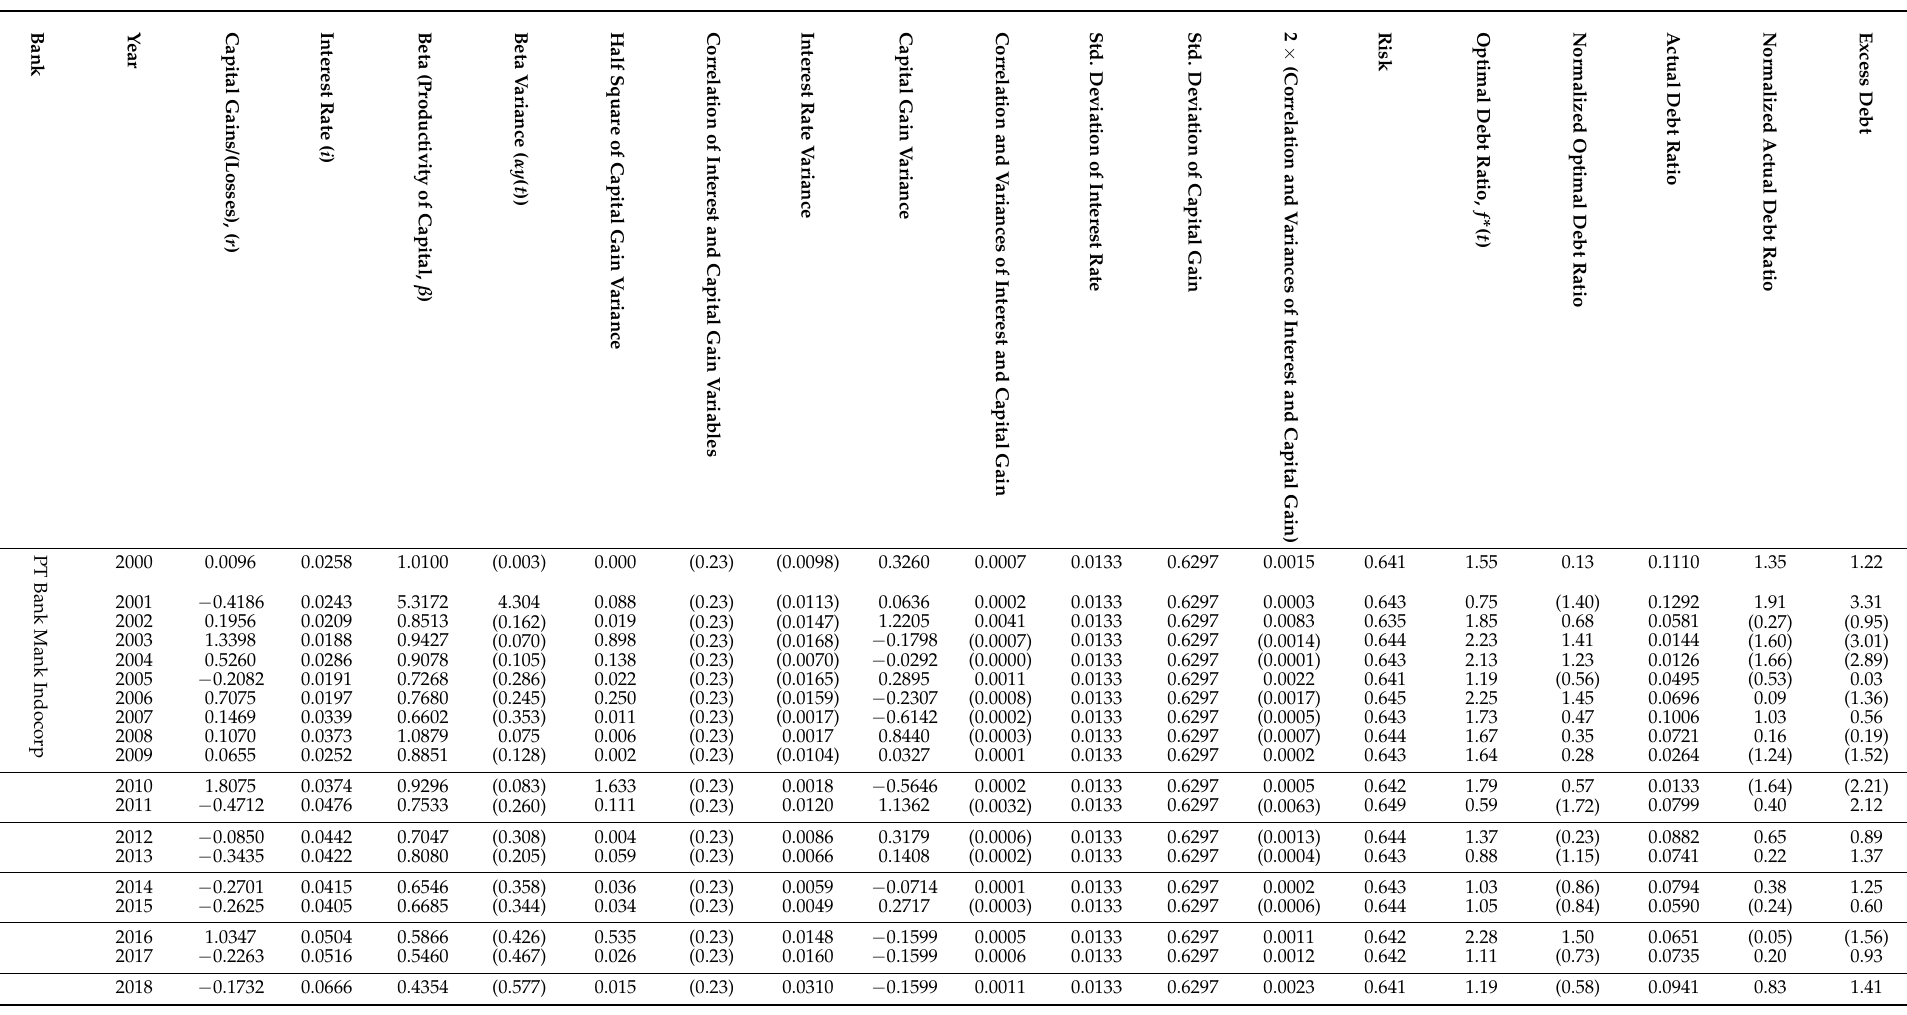
Table A5. Calculations of Optimal and Excess Debt: PT Bank Mank